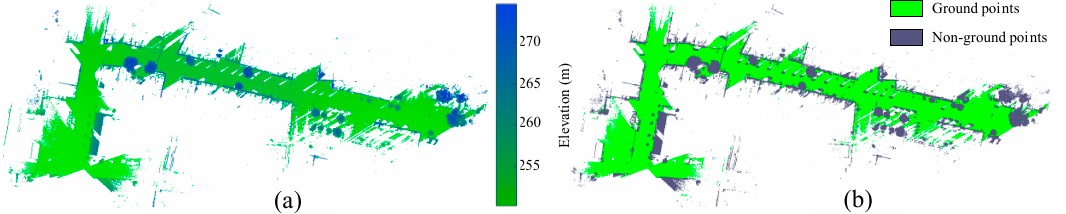
Figure 3. Data II (urban scene). ( a ) Original point cloud; ( b ) Rough ground classification.